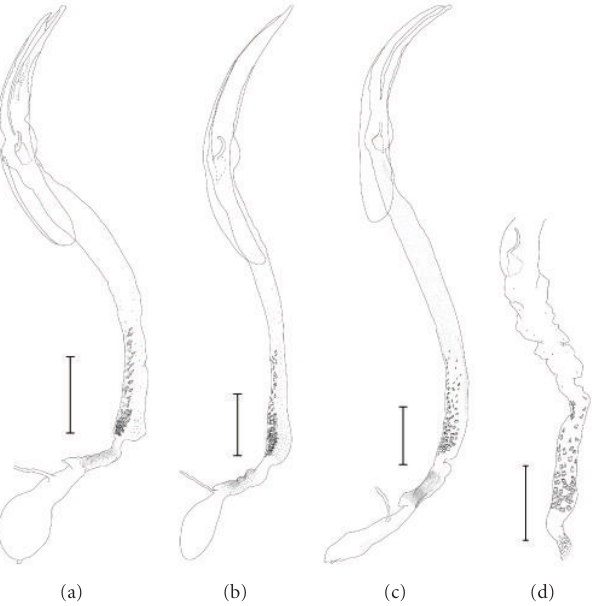
Figure 10: The median lobe with endophallus of Agelasta ( Dissosira ) spp. in lateral view. (a) A. ( D. ) yonaguni ; (b) A. ( D. ) nigrostictica ;